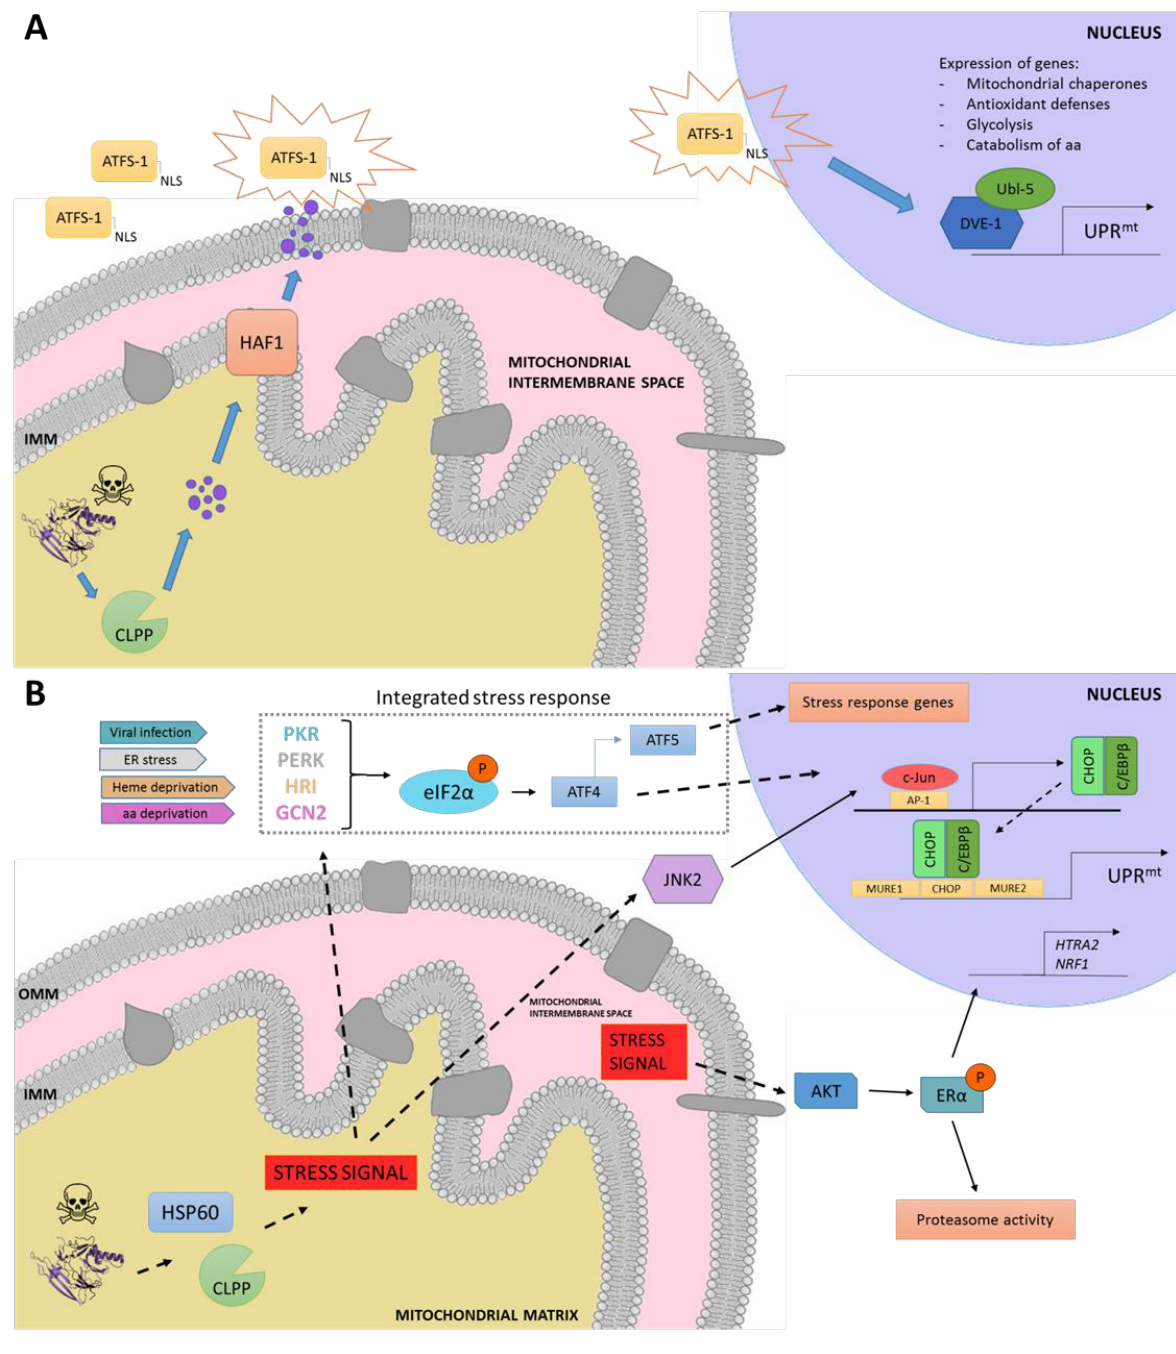
FIGURE 3: Overview of the UPR mt in worms and mammals. (A) UPR mt in C. elegans. When the capability of the mitochondria to process unfolded proteins is compromised, the mitochondrial unfolded protein response (UPR mt ) is activated. Upon mitochondrial stress, the protease CLPP degrades the excess of unfolded proteins, and the resulting fragments are moved across the inner mitochondrial membrane (IMM) to the intermembrane space, where they diffuse through passive diffusion to the cytoplasm. ATSF-1 import inside mitochondria is prevented, and its activation upon the sensing of the degraded peptides shuttles ATFS-1 to the nucleus, granted by the nuclear localization sequence (NLS). (B) Retrograde signaling in mammals upon proteotoxic stress . The excess of unfolded proteins is sensed by quality control proteases and chaperones such as HSP60 and CLPP, and the stress signal is processed via two different pathways, the activation of the CHOP gene via the JNK pathway and the induction of the integrated stress response (ISR), respectively. On the one hand, JNK2 processes the stress signal from the mitochondrial matrix to activate the transcription factor c-Jun, which binds to AP-1 elements and induces the expression of CHOP and C/EBPβ. The CHOP-C/EBPβ complex then binds to the CHOP ele- ment, which is flanked by two mitochondrial unfolded protein response elements (MURE1 and MURE2), activating the transcription of UPR mt - responsive genes. On the other hand, viral infection, ER stress, heme deprivation and amino acid insufficiency activate PRK, PERK, HRI and GCN2, respectively, giving rise to the phosphorylation of eIF2α, the core of the ISR. This leads to the preferential translation of ISR-specific mRNAs, such as ATF4, the main effector of the ISR. ATF4 enhances the transcription of ATF5, leading consequently to the transcription of target genes. Moreover, a matrix-independent IMS- specific UPR mt has also been reported. Stress signals coming from the accumulation of unfolded proteins in the IMS leads to the AKT-mediated phosphorylation of ERα, resulting in the expression of HTRA2, NRF1, and an increase in the activity of the